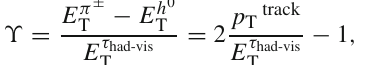
The ϒ distributions for left- and right-handed τ leptons have different shapes in case of the τ ± → h ± N π 0 ν , N ≥ 1 decay modes, while for the τ ± → h ± ν mode the polarisa- tion sensitivity comes mostly from different acceptances and efficiencies. The branching ratio of the τ ± → h ± π 0 ν decay mode also exceeds the total branching ratio of the remaining single-prong τ had decay modes combined. Most of the sensitivity originates from the τ ± → h ± π 0 ν decays. The τ ± → h ± ν and other remaining modes have similar individual sensitivities and they also make a signifi- cant contribution to the overall polarisation